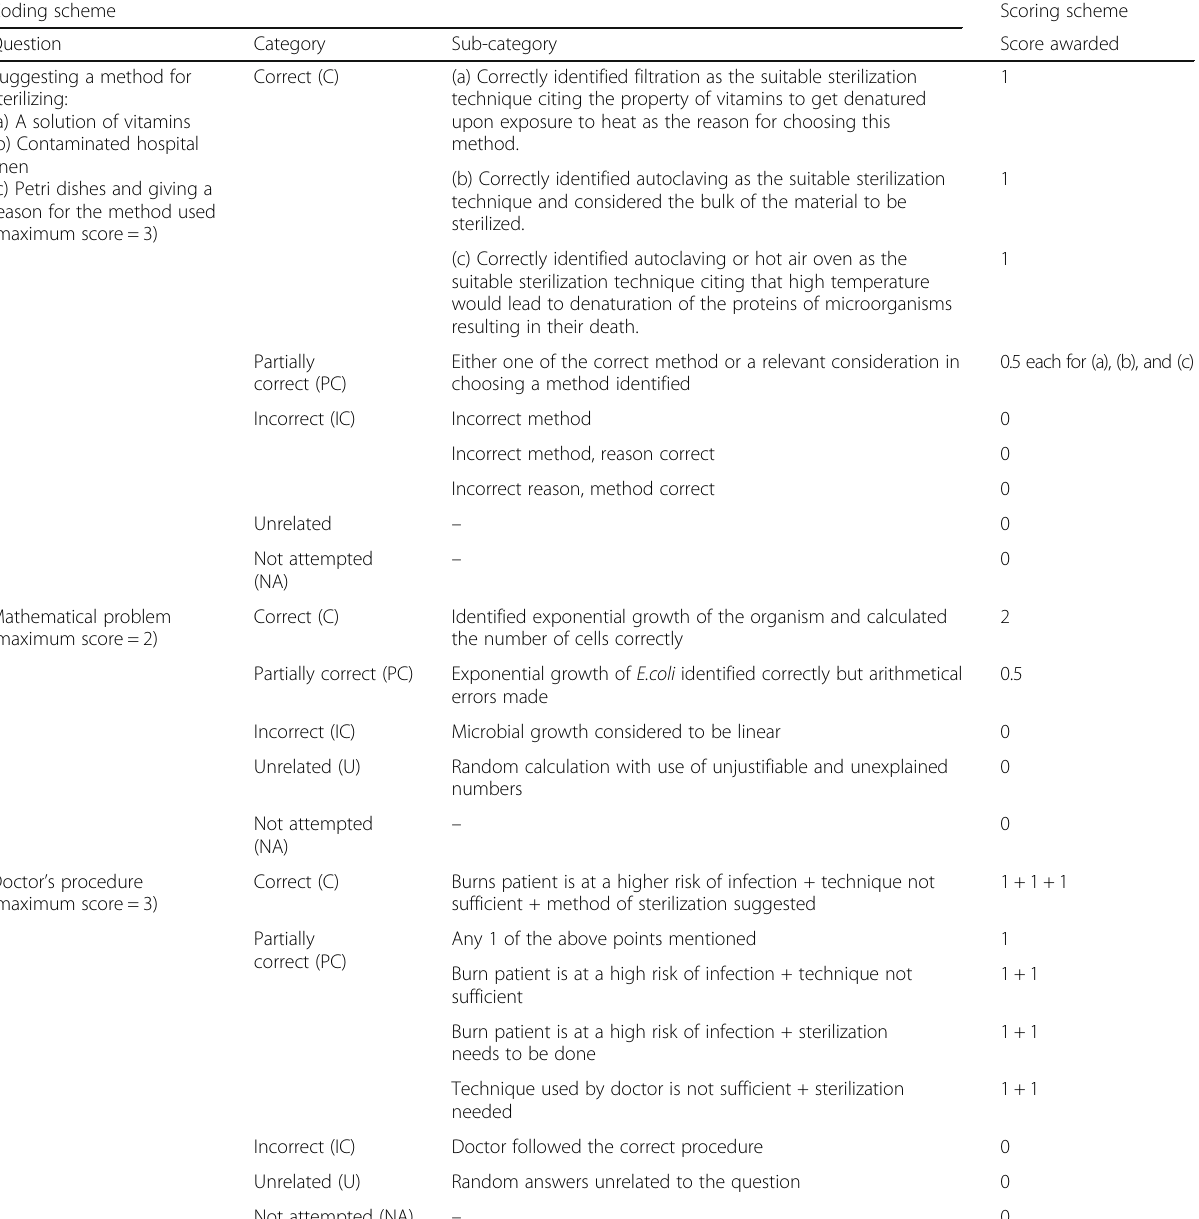
Table 3 Coding and scoring scheme used in the study Coding scheme Scoring scheme